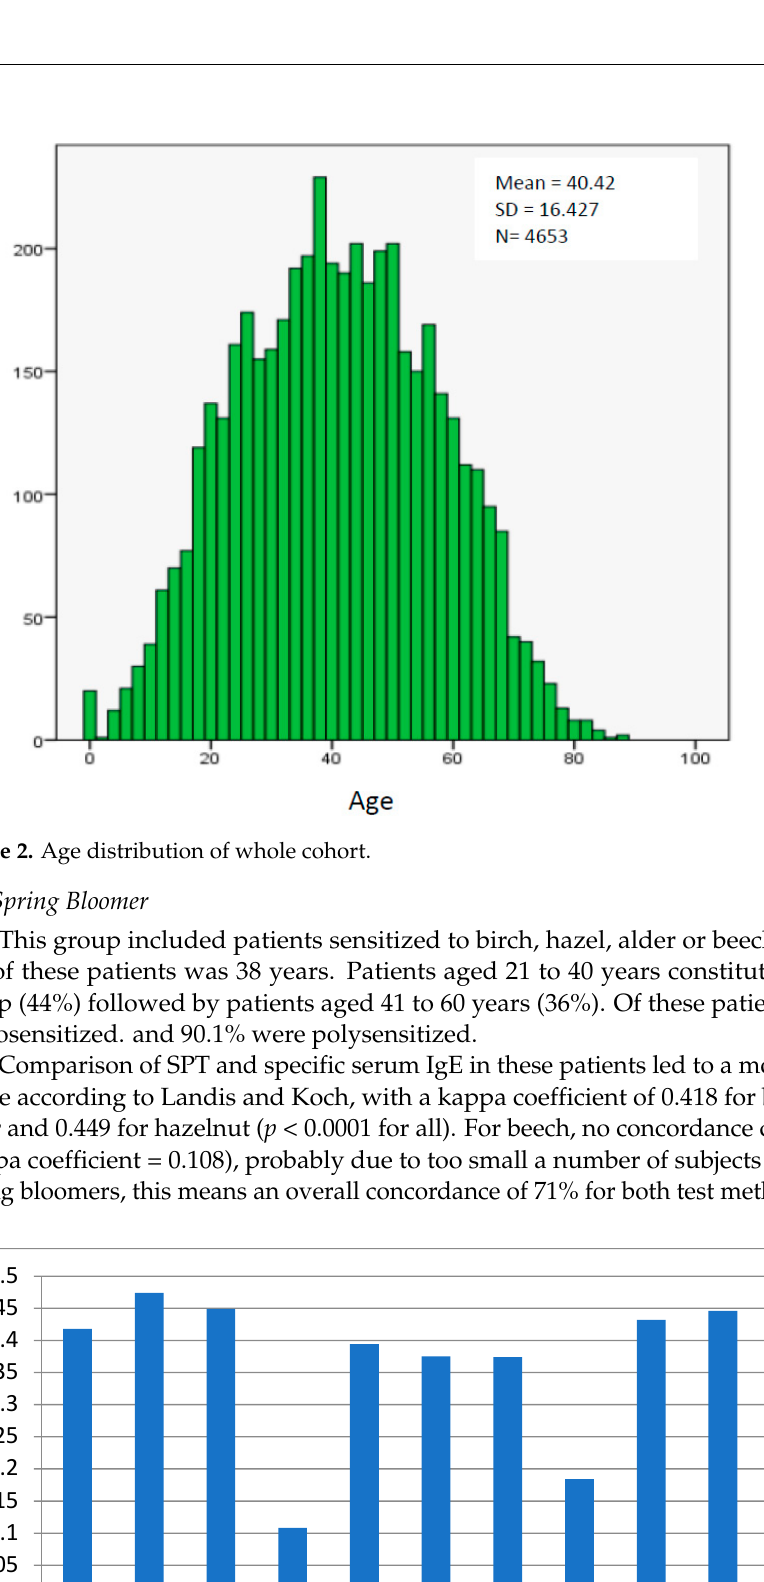
Figure 4. Overall concordance of SPT (intradermal test for mold) and specific serum IgE.